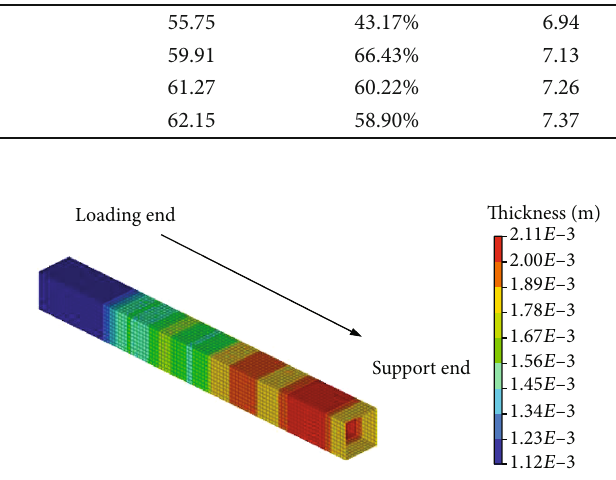
Figure 24: Thickness distribution of the designed tube.